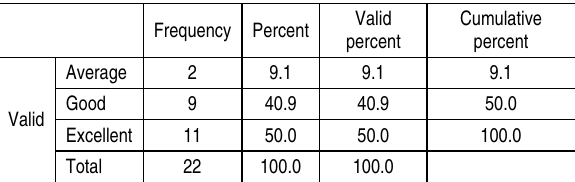
Table 14. Students’ motivation to participate in entrepreneurship activities through the SBIC project